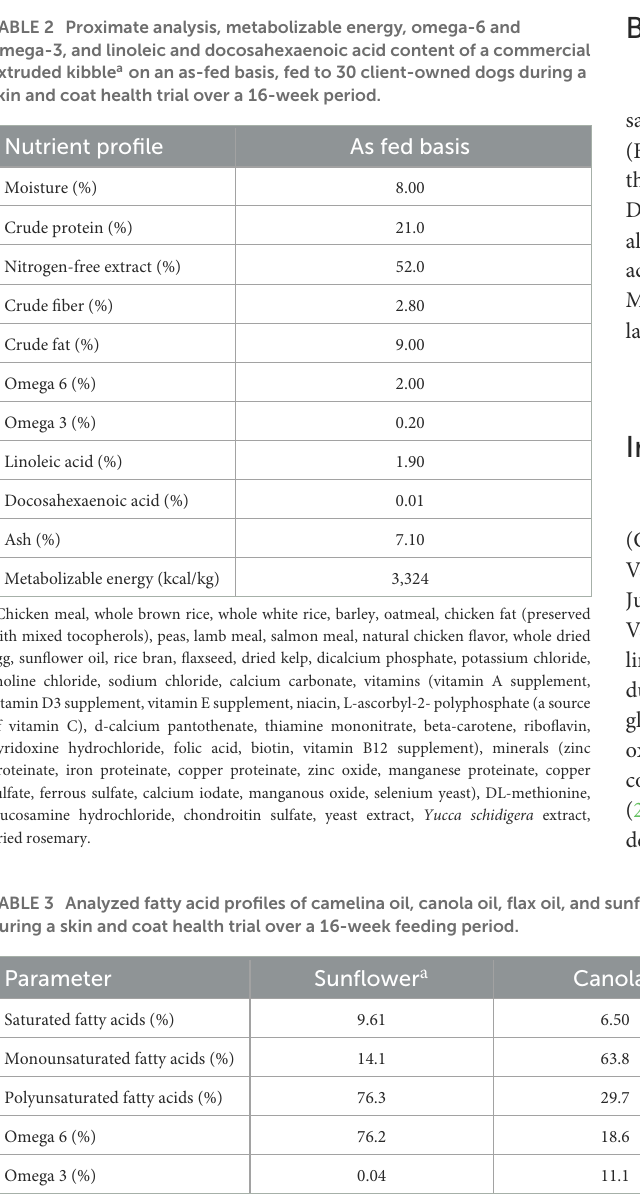
TABLE 2 Proximate analysis, metabolizable energy, omega-6 and omega-3, and linoleic and docosahexaenoic acid content of a